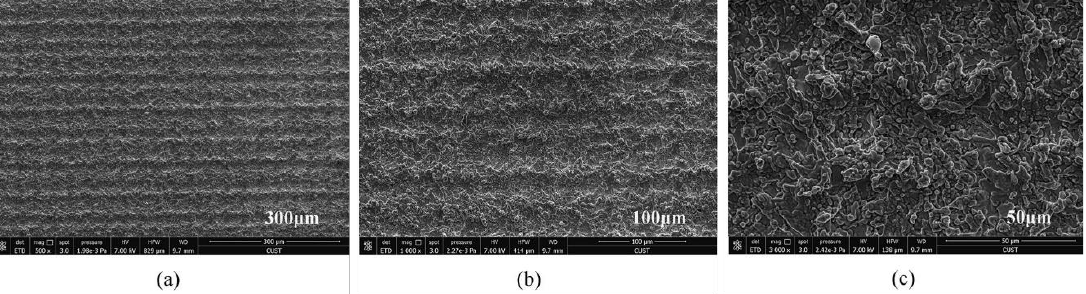
Figure 18. SEM image of laser-induced superhydrophobic surface when the scanning spacing is less than the beam diameter ( a ) 300 μm length scale ( b ) 100 μm length scale (c) 50 μm length scale (Reprinted with permission from Ref. [47]. 2021, Zhang, L.).